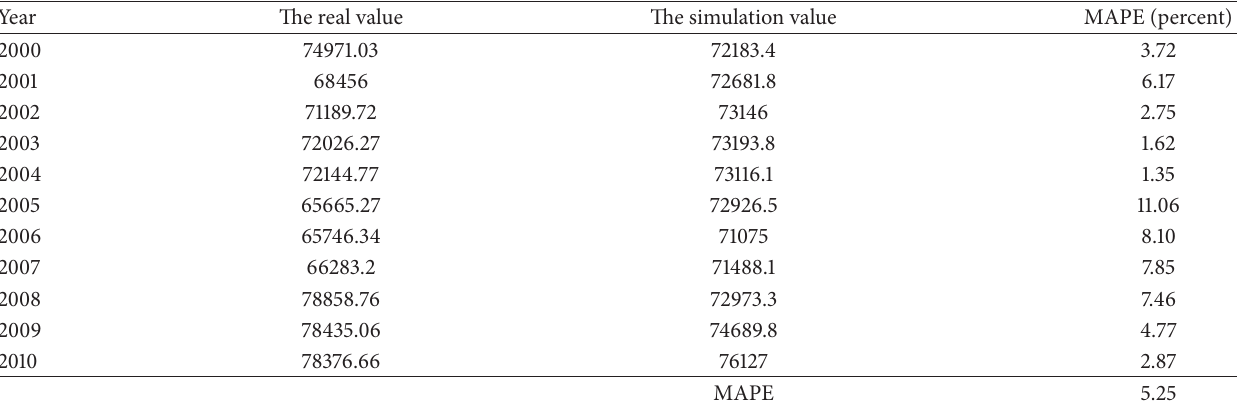
Table 3: The design of scenarios.